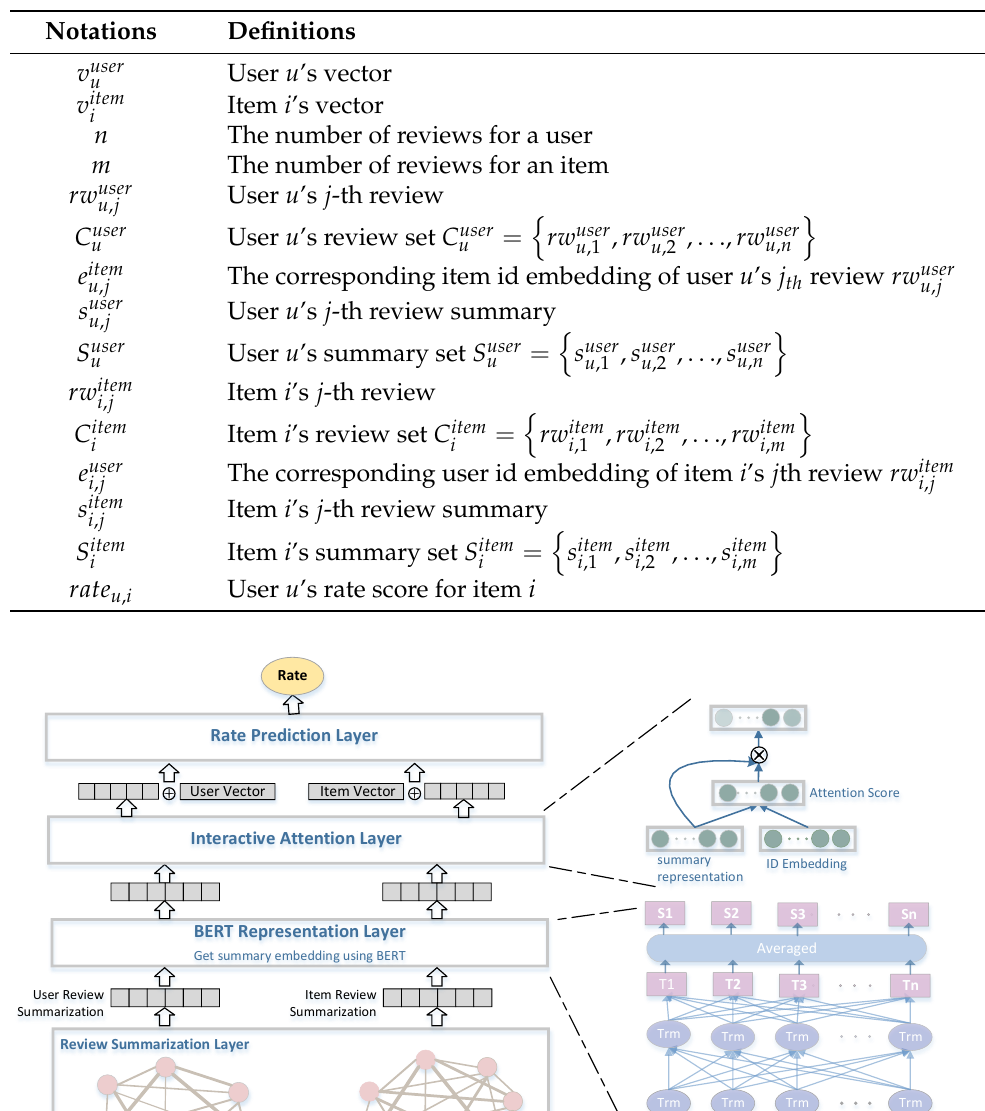
Table 1. Notations.